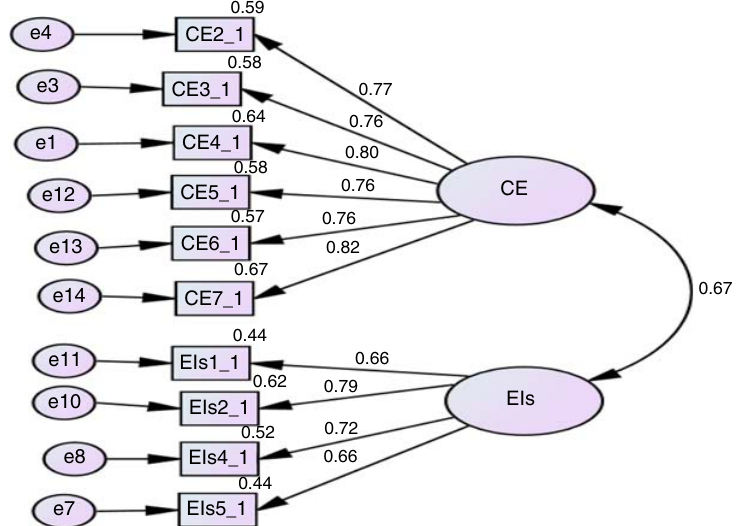
Figure 3. Measurement model for university ’ s role